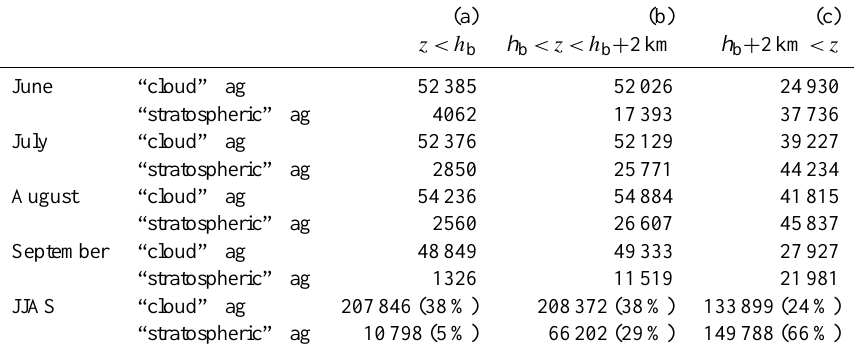
Table 1. Number of the “cloud” and “stratospheric” flags from the CALIPSO Level 2 VFM data in the latitude range of 60–82 ◦ S and in the altitude range of 8–20km in 2007 when (a) z <h b , (b) h b <z <h b + 2km, and (c) h b + 2km <z , where z and h b are the altitude and the tropopause height, respectively, following the definition of Wilcox et al. The percentages in parentheses indicate the percentage of each flag in the given altitude